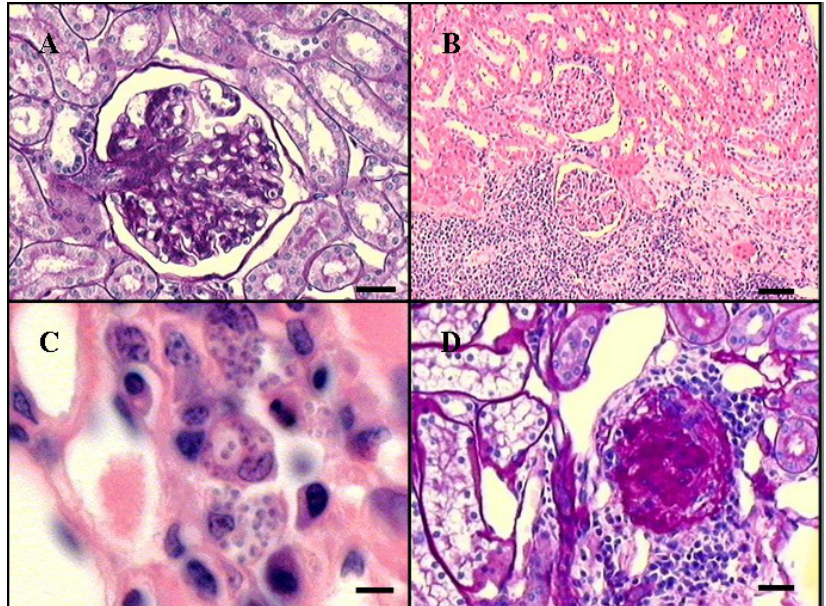
Figure 3: Microphotograph of a renal lesion in symptomatic VL seropositive dogs. A: Membranoproliferative glomerulonephritis. PAS staining. Bar: 12.5 µ m. B: Inflammatory mononuclear infiltrate. HE staining. Bar: 25 µ m C: Macrophages with amastigote forms of Leishmania. HE staining. Bar: 5 µ m. D: Total glomerular sclerosis. PAS staining. Bar: 25 µ